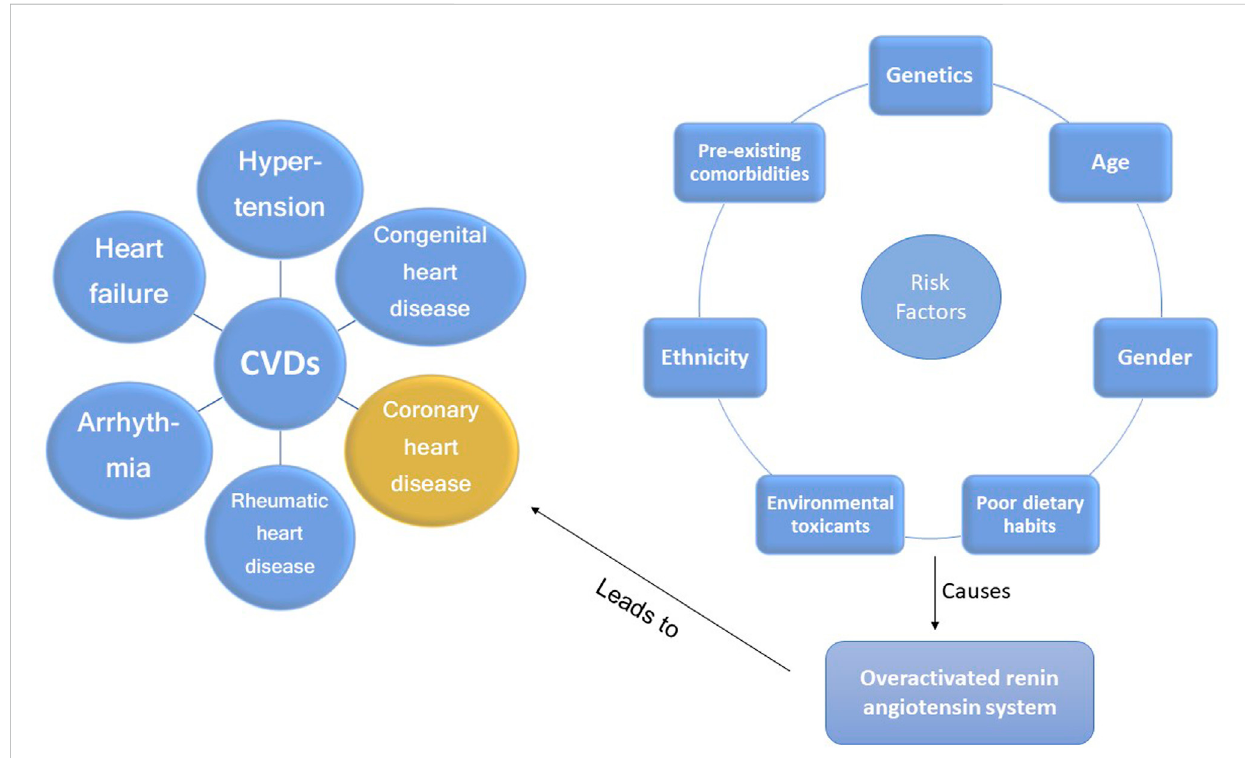
FIGURE 1 Risk factors that can accelerate the development of coronary heart disease via the overactivated